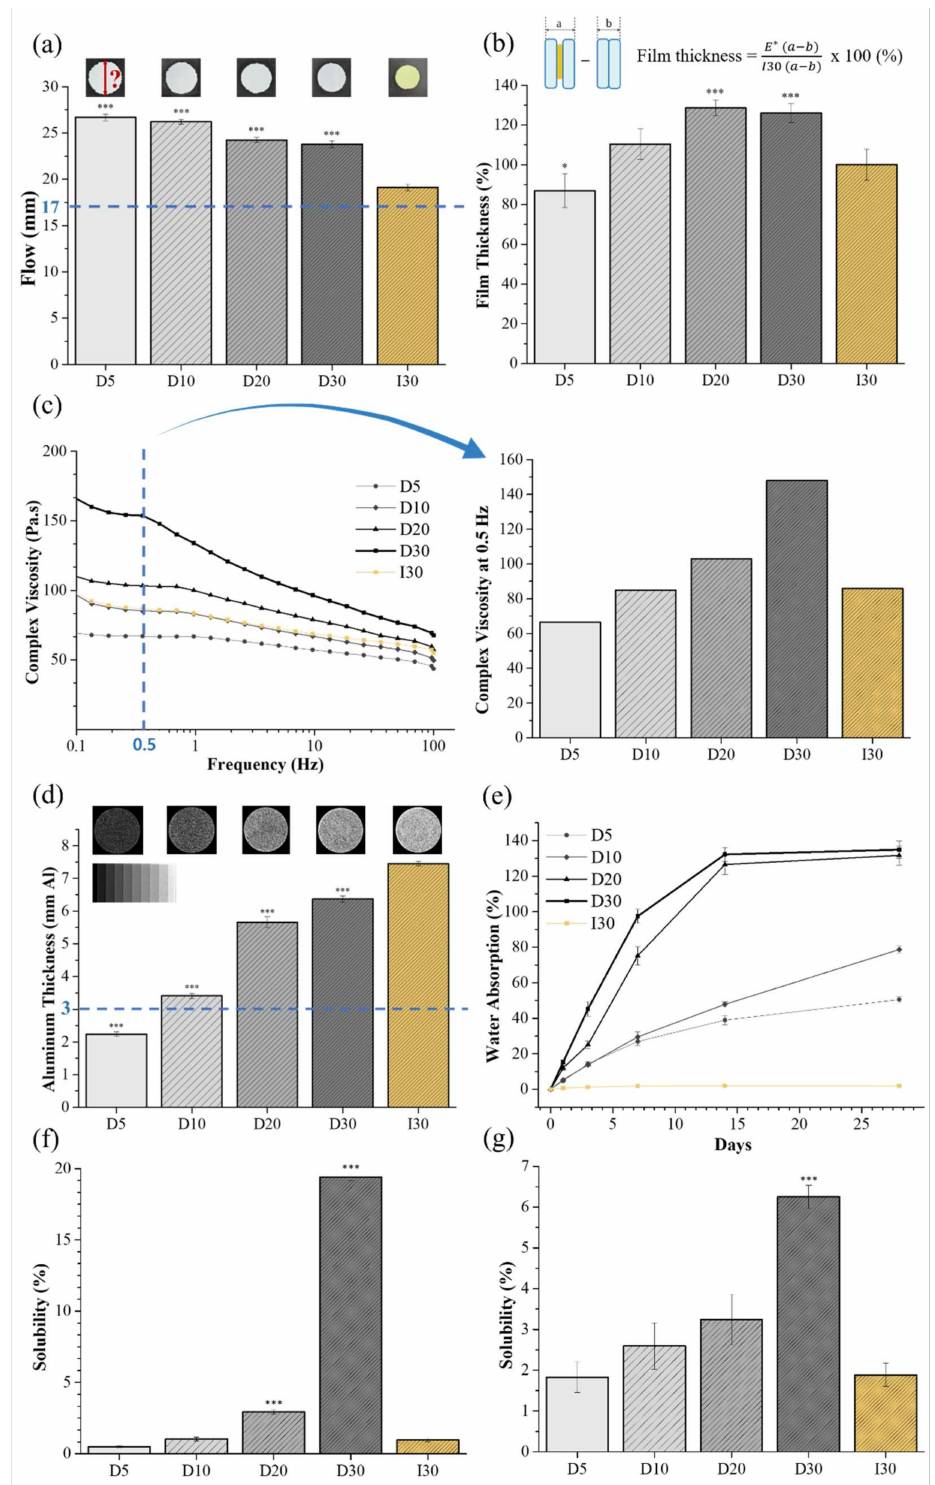
Figure 1. Physical properties of NaI-incorporated paste (NaI@P). ( a ) Flowability. ( b ) Film thickness. ( c ) Viscosity. ( d ) Radiopacity. ( e ) Water absorption by weight change over 28 days. ( f ) Solubility from specimen. ( g ) Solubility from extract. Statistical significance was calculated using a one-way analysis of variance (ANOVA) followed by Tukey’s honestly significant difference compared to the control (I3O). * p < 0.05, *** p <